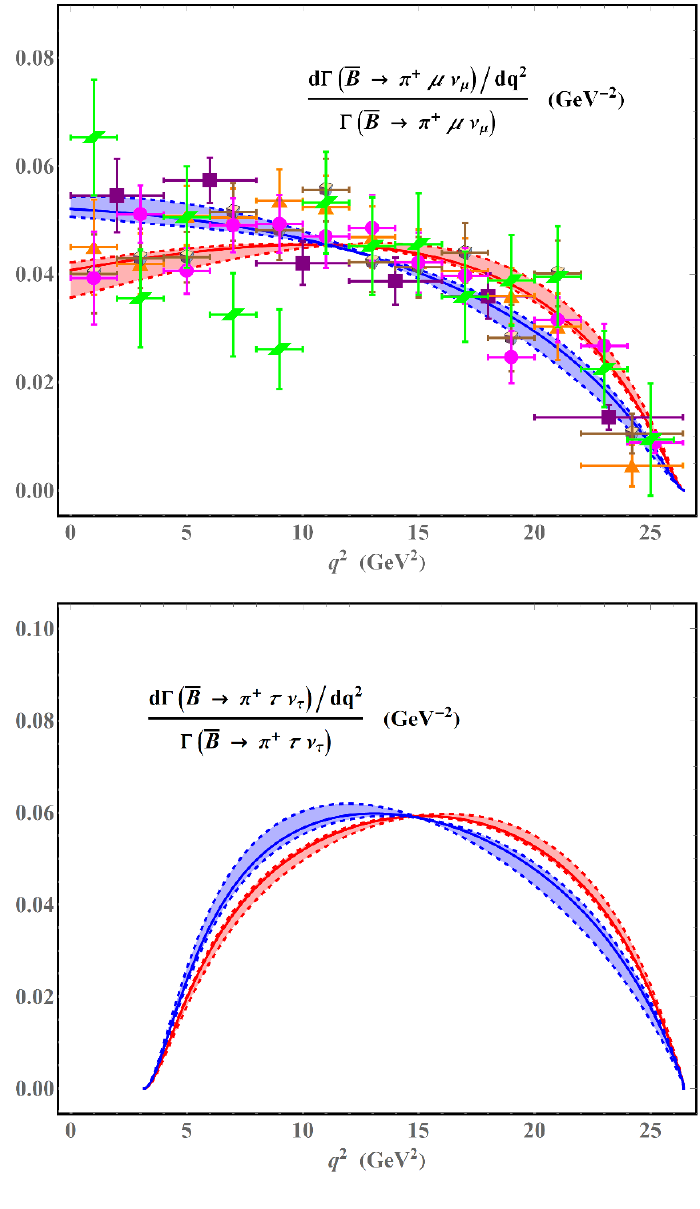
Figure 8 . The normalized di(cid:11)erential q 2 distributions of the semileptonic B ! (cid:25)‘(cid:23) ‘ ( ‘ = (cid:22) ; (cid:28) ) decays with the form factors computed from the B -meson LCSR with an extrapolation to the whole kinematical region (pink bands) and from the pion LCSR with the z -series expansion (blue bands). We also present the experimental data points B ! (cid:25)(cid:22)(cid:23) (cid:22) from [79] (purple squares), [80] (orange triangles), [77] (brown hexahedrons), [81] (magenta circles) and [78] (green parallelograms).